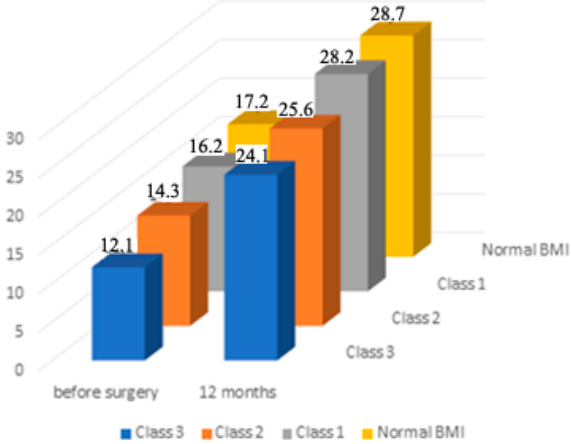
Figure 2. Stage 1—Physical functioning before and 12 months after surgery. There was no significant difference in the mental health component of the SF-36 scale in all study groups ( p > 0.05, Figure 3).